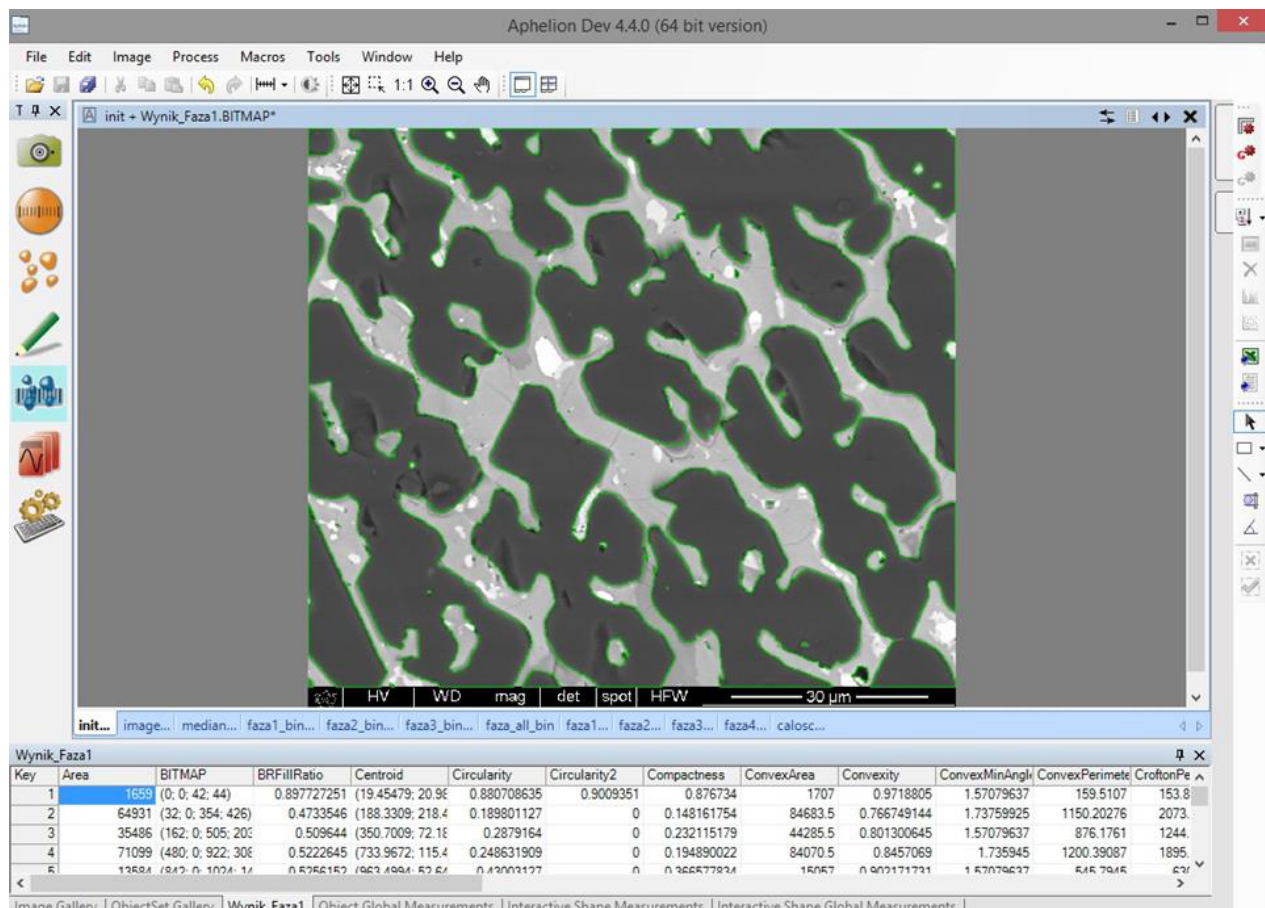
Figure 16. User interface of Aphelion during measurements of the P1 phase. Table 4. Percentage distribution of analyzed phases P1, P2, P3, and P4 in the image, corresponding to Figure 15l (2000×) and Figure 17 (500×).